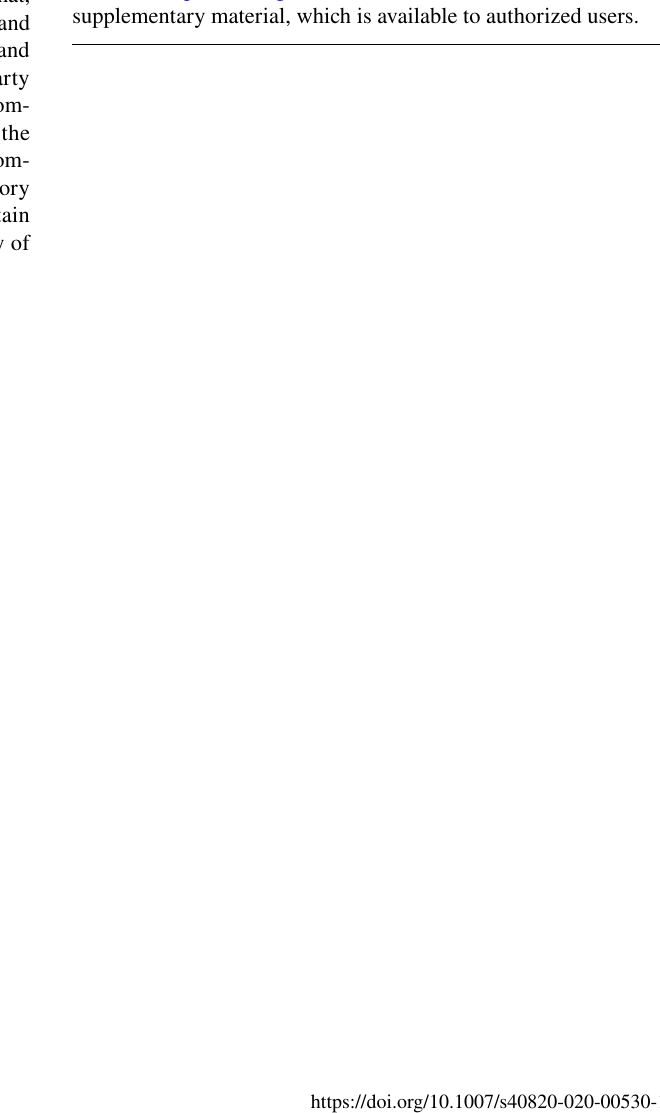
Electronic supplementary material The online version of this article (https ://doi.org/10.1007/s4082 0-020-00530 -1) contains supplementary material, which is available to authorized